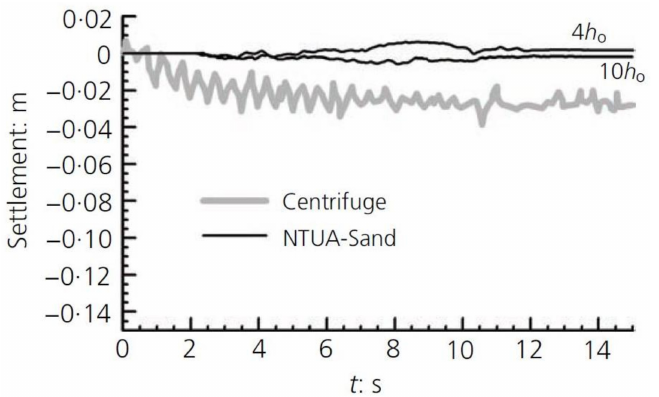
Figure 15. Comparison of surface settlements from numerical simulation and centrifuge testing on CS-treated sand